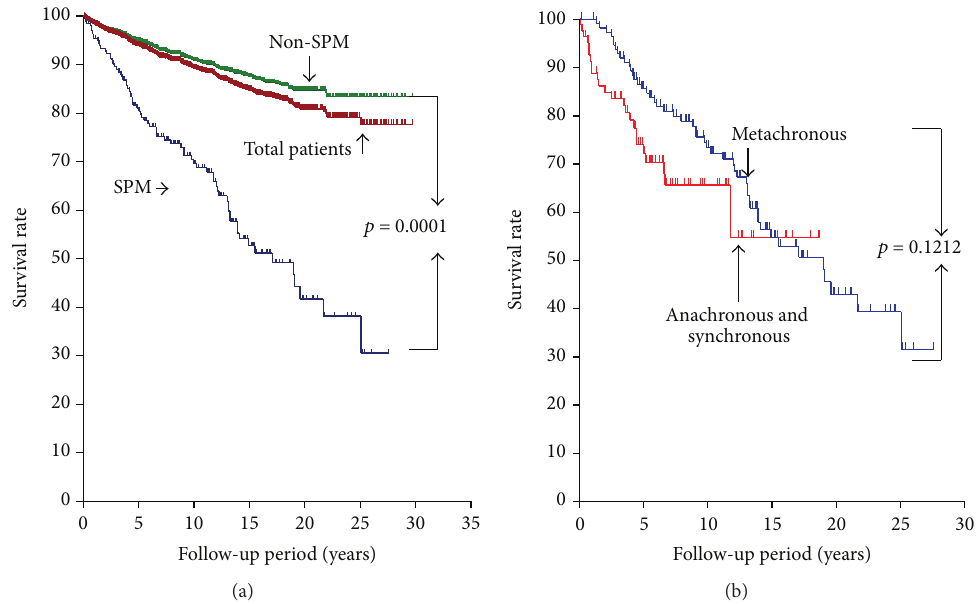
Figure 3: (a) Kaplan-Meier survival curves of thyroid cancer and overall mortality of the SPM and non-SPM patients. (b) Overall survival rates between metachronous group and anachronous with synchronous